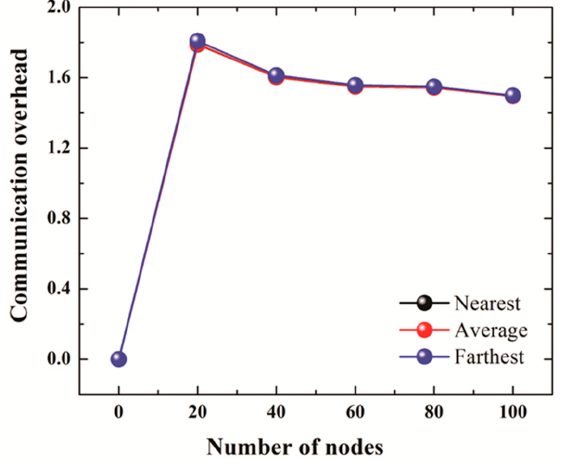
Figure 11. Communication overhead for different CH positions.